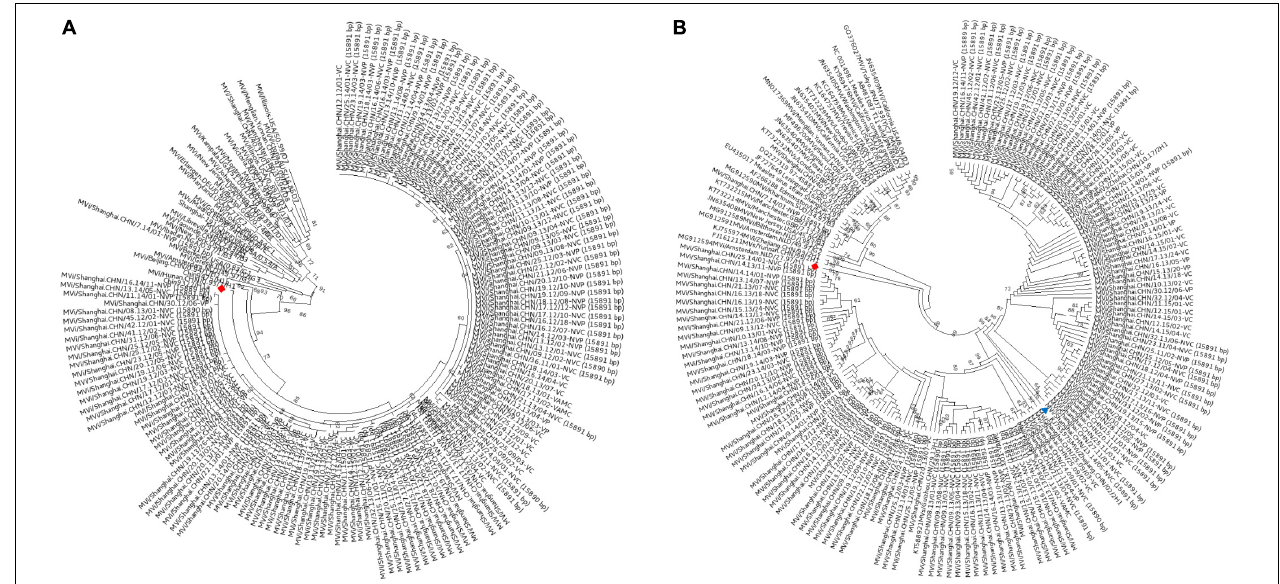
FIGURE 1 | Genotyping of MV strains circulating in Shanghai, China, between 2009 and 2017. (A) Based on the full-length 150 amino acid sequence of the N terminal 450 bp in the nucleoprotein region; (B) H gene. A maximum-likelihood phylogenetic reconstructed by MEGA 6 was performed with 147 Shanghai-MV strains and 24 genotype-references from the WHO’s list for genotyping. (cid:7) : reference strains from genotype H1; (cid:78) : reference strains from clusters H1-A.